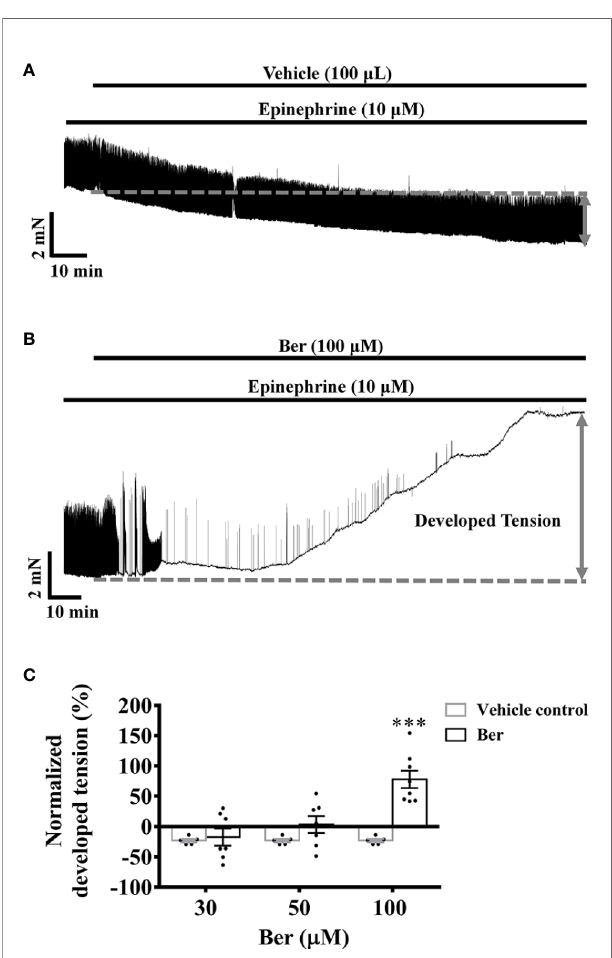
FIGURE 3 | Berberine increased the tension of the freshly isolated left ventricular muscle (LVM) strips pretreated with epinephrine. (A, B) Original isometric tension recordings showing that berberine (100 µM) increased the tension and abolished the epinephrine-evoked phasic contractions in LVM strips. (C) Summary data showing that the effect of berberine on the tension of the LVM strips pretreated with epinephrine. The numbers of repeats are as follows: 30 µM and 50 µM Ber, n = 7, N = 7; 100 µM Ber, n = 8, N = 8; n and N are the numbers of LVM strips and rats, respectively. Ber stands for berberine. ***p < 0.001 vs. vehicle control group; two-way ANOVA with Sidak's multiple comparisons